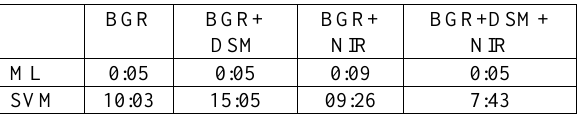
Table 5. Processing time (in hour) required for the classifications based on the ML vs. SVM algorithms (with Xeon 3.70 GHz processor and 32 Go RAM)